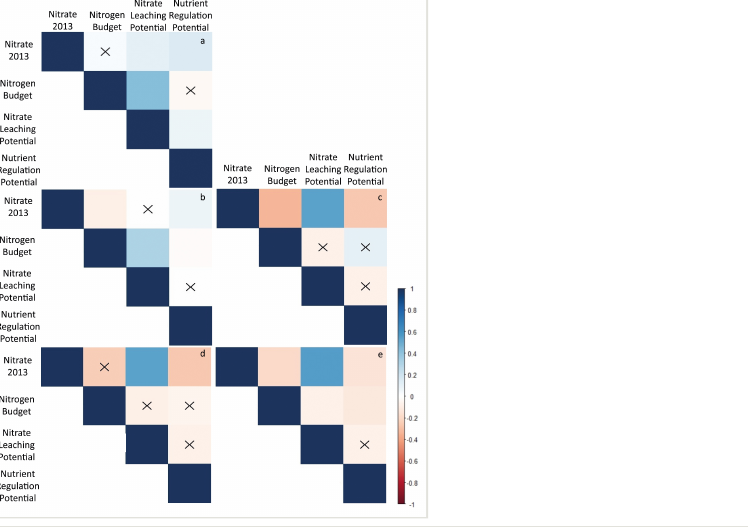
Figure 12. Correlograms for each dataset (a: SH_M; b: SH_LG; c: B_LG_B2; d: B_LG_B4; e: